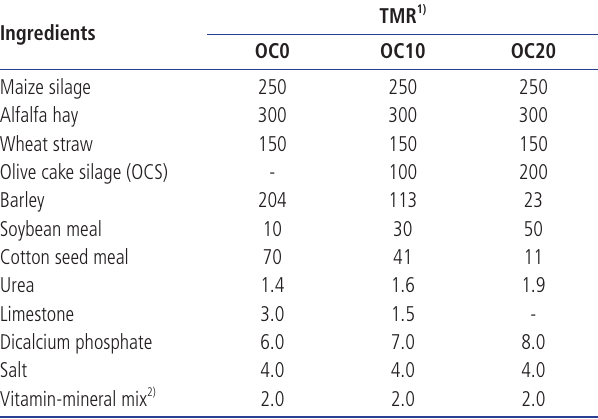
Table 1. Ingredients composition of the experimental TMR (g/kg DM)